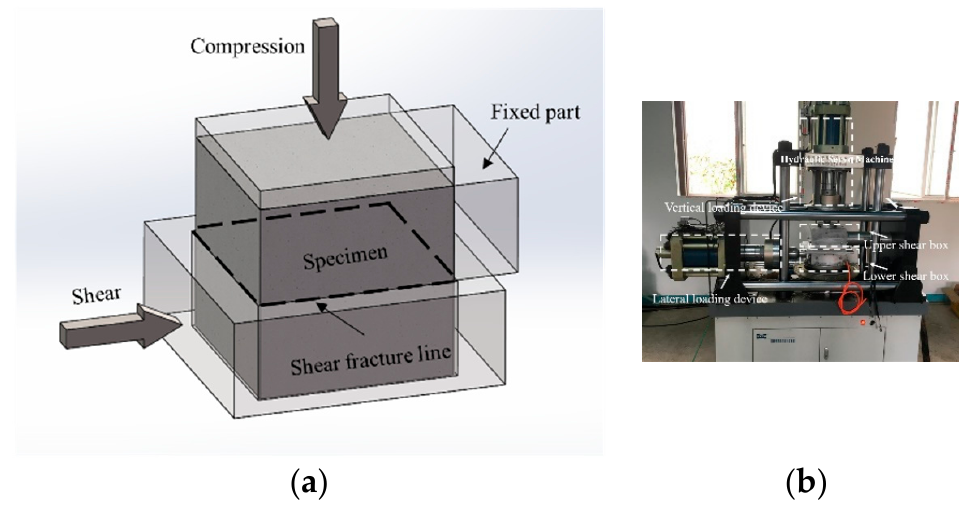
Figure 1. Loading schematics and loading devices. ( a ) loading device; ( b ) loading process.